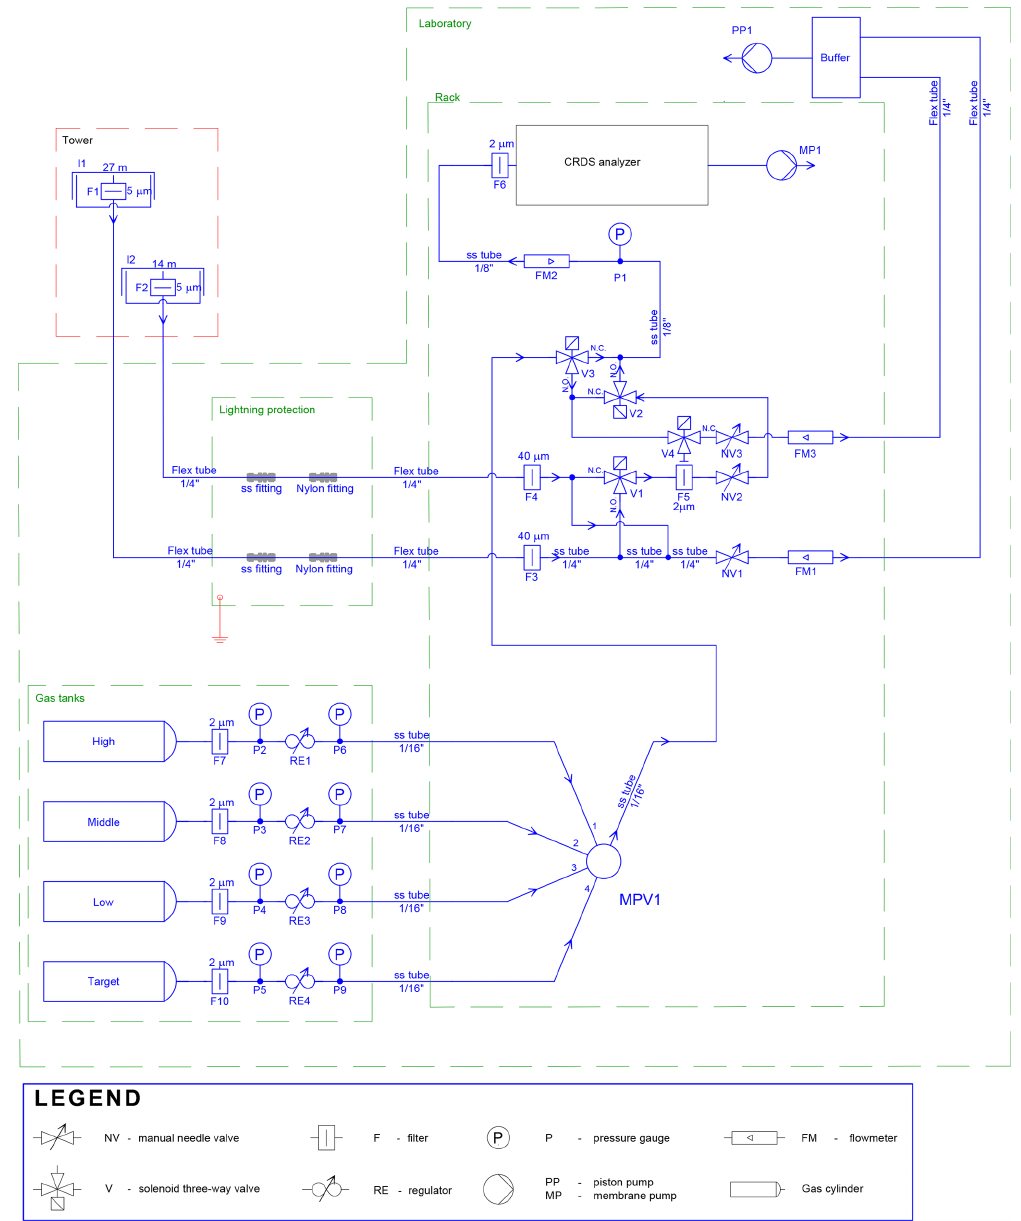
Figure 3. Air flow diagram of Ambarchik greenhouse gas measurement system. See Sect. 2.3 for a description of component abbreviations. “ss” refers to stainless steel throughout the